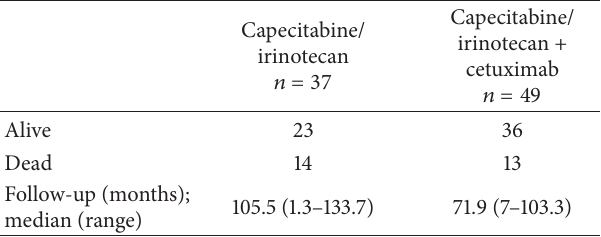
Table 3: Follow-up of patients with locally advanced rectal cancer receiving capecitabine/irinotecan +/ − cetuximab based chemora- diotherapy as preoperative treatment ( 𝑛 = 98 ).